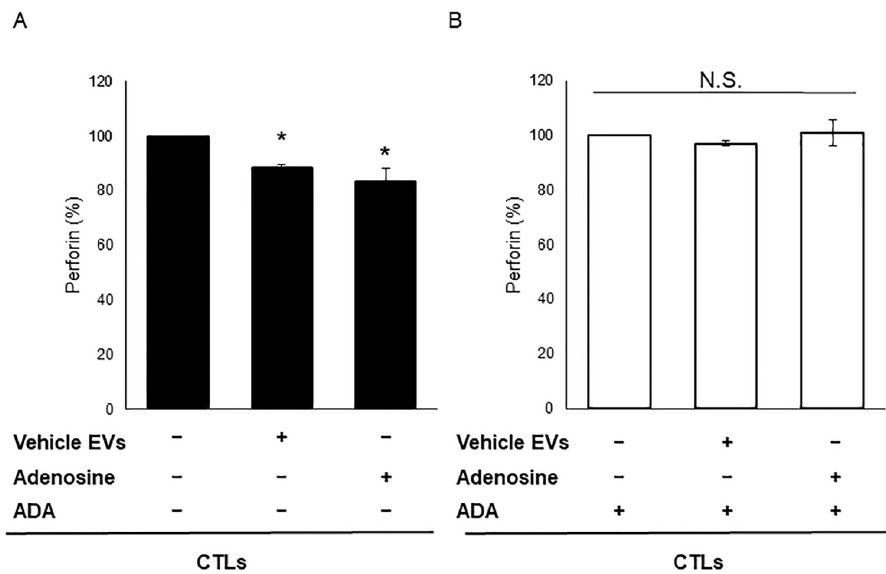
Fig 5. Effect of EVs containing adenosine on perforin secretion by CTLs. Perforin protein levels in medium from CTLs were measured by ELISA after 24 h of stimulation with adenosine or EVs from vehicle-treated D3H2LN cells (vehicle EVs). (A) Levels in the absence of adenosine deaminase (ADA). (B) Levels in the presence of ADA. Data represent the mean ± S.D. (n = 3). P < 0.05 (Tukey–Kramer test). All experiments were performed using three biological replicates, and each sample was compared with its individual control; therefore, the control has no standard deviation.